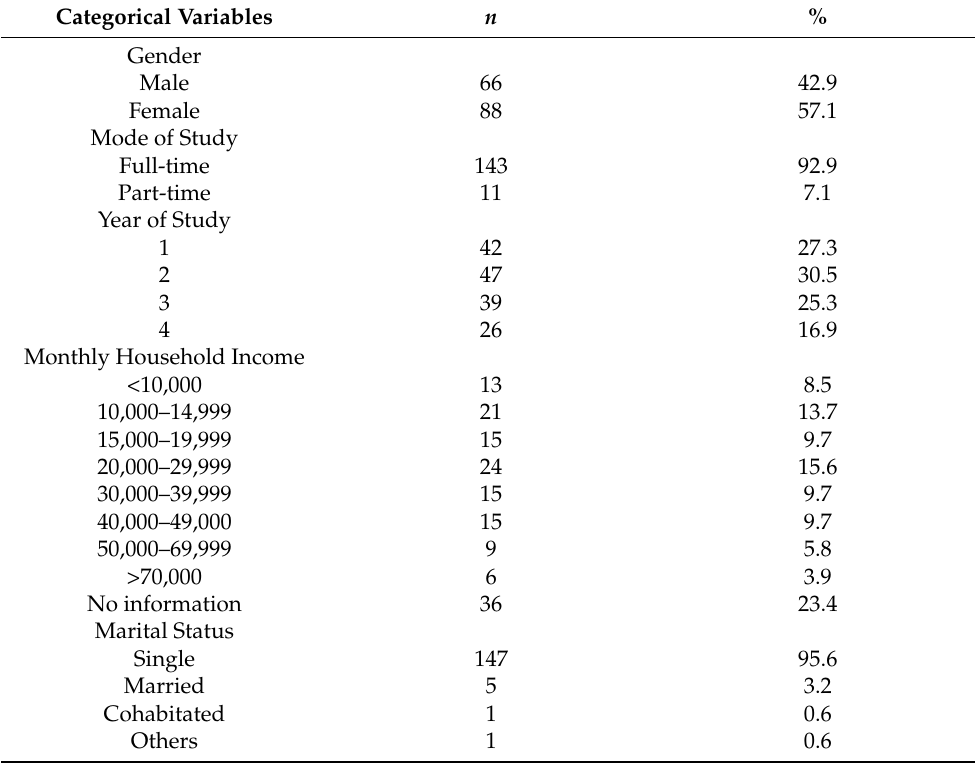
Table 1. Demographic characteristics of the student participants ( N =